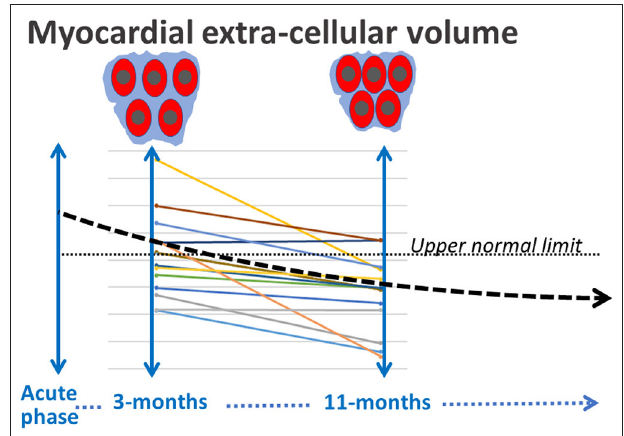
FIGURE 3 | Schematic representation of the progressive decrease during the first year of the myocardial ECV, presumably in line with a delayed resolution of the interstitial